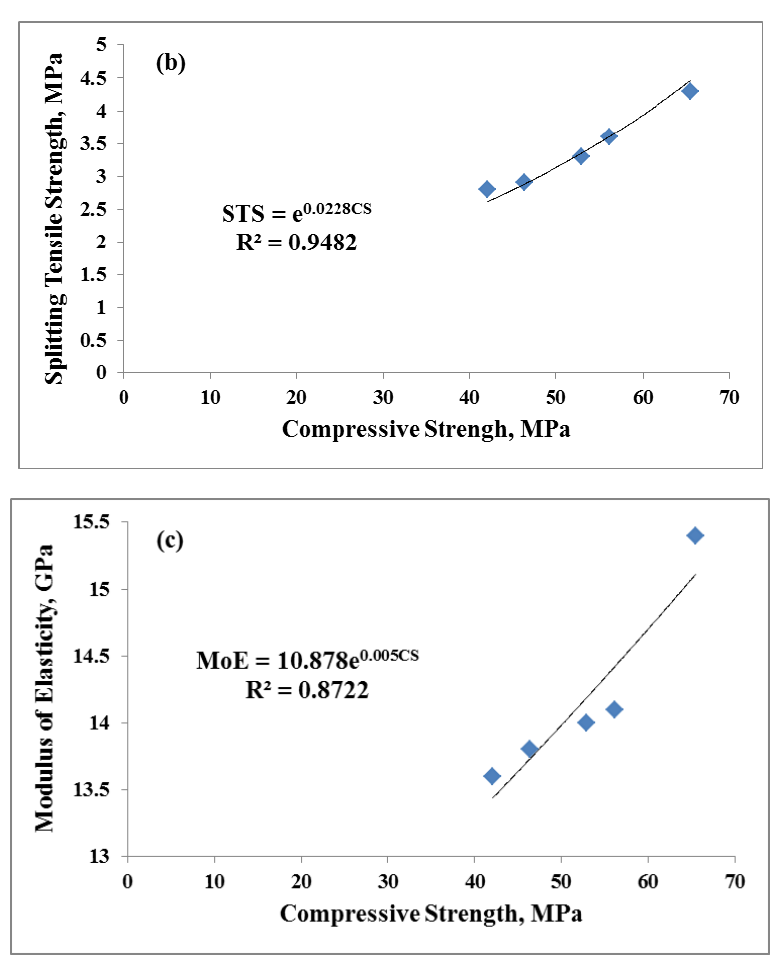
Figure 10 . Relationship between CS ( a ) FS, ( b ) STS and ( c ) MoE of AAMs . Figure 10. Relationship between CS ( a ) FS, ( b ) STS and ( c ) MoE of